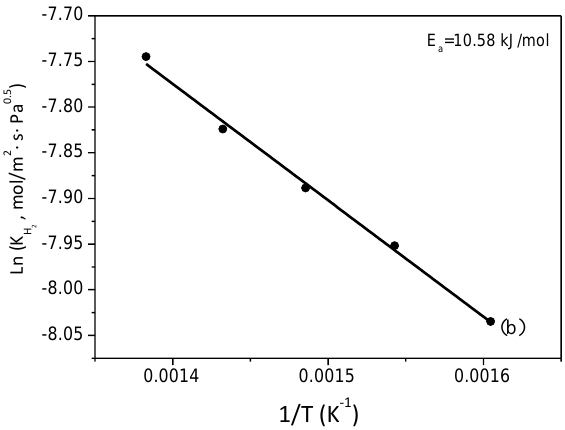
Figure 5. Permeation behavior for out–in operating mode: ( a ) Overall pressure and temperature effects on H 2 permeate fluxes (deviation from origin interception marked as a red vertical band) and ( b ) determination of the activation energy.